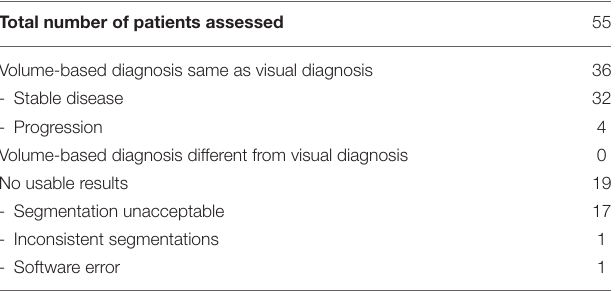
TABLE 3 | Characteristics of 55 patients included in the evaluation of EASE in clinical practice.